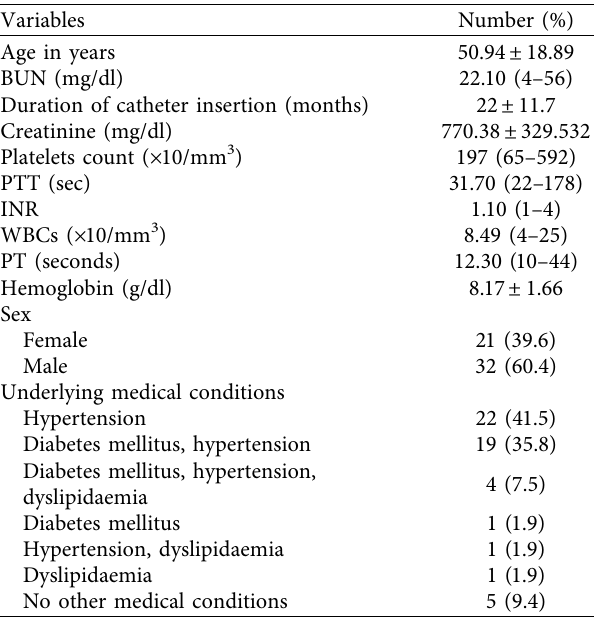
Table 1: Distribution of patients ( n � 53) according to their de- mographic characters, lab results, and chronic